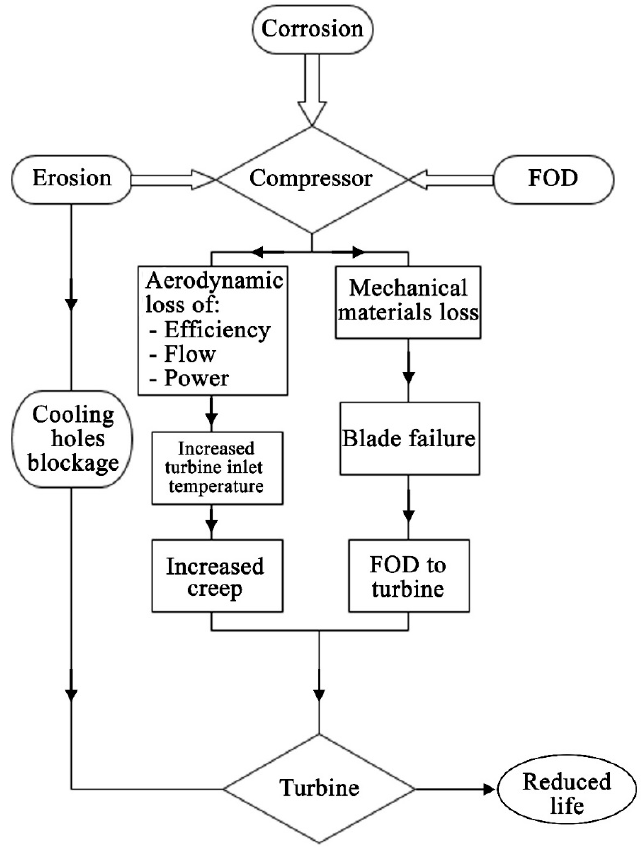
Figure 2. Gas turbine engine degradation factors.